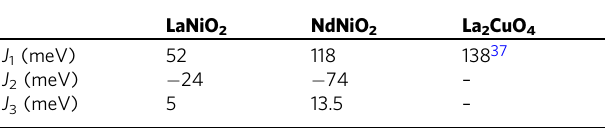
Table 3 Estimated exchange interactions for the Ni sub- lattice in LaNiO 2 and NdNiO 2